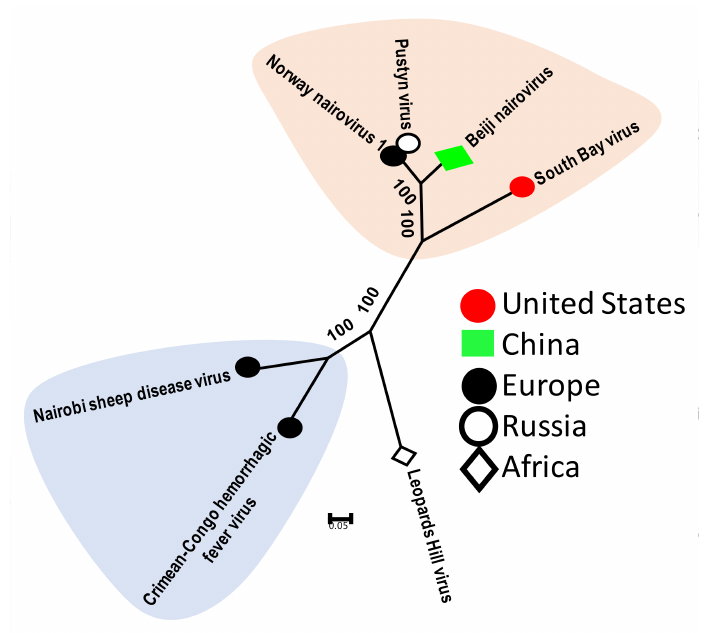
Figure 1. Phylogenetic relatedness of newly identified and known tick nairoviruses. This analysis involved seven amino acid sequences of the viral polymerase gene. Genbank accession numbers of sequences used for phylogenetic analysis are: ASY03236 Norway nairovirus 1, AXQ59276 Beiji nairovirus, AAZ38661 Crimean–Congo hemorrhagic fever virus, YP_009111284 Leopards Hill